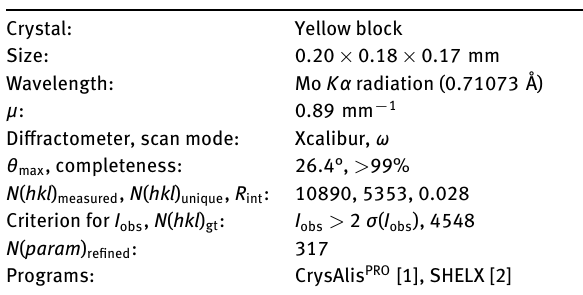
Table 1: Data collection and